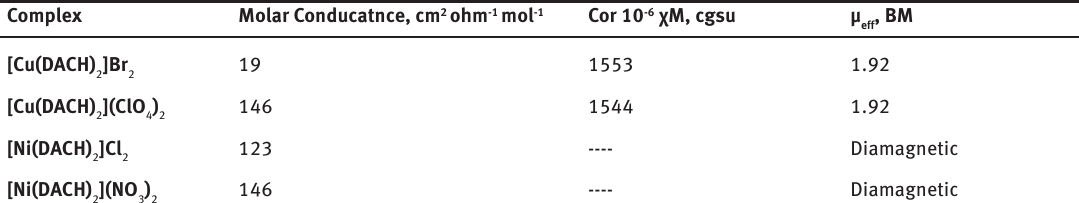
Table 2: Molar conductance and magnetic susceptibilities of metal (ii) complexes with DACH. Complex